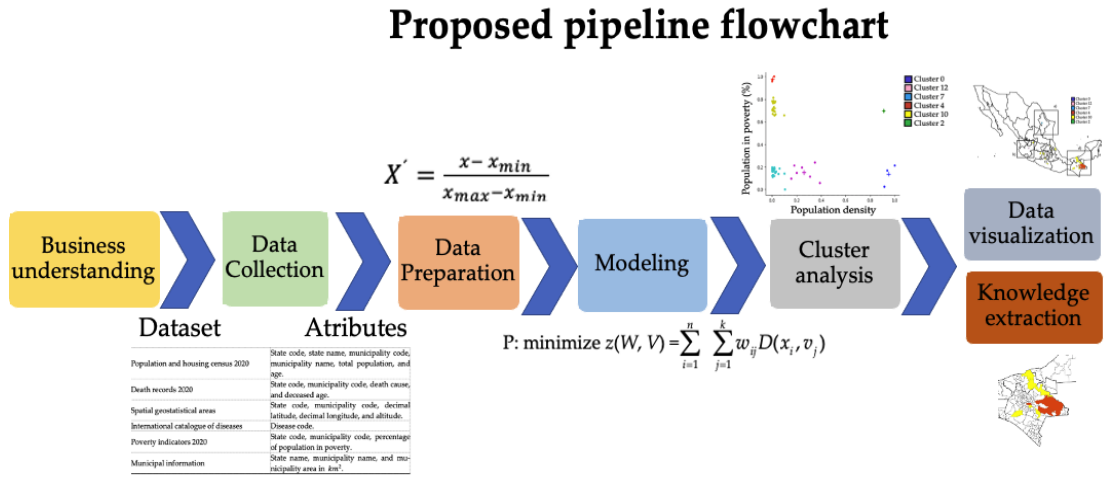
Figure 1. Pipeline